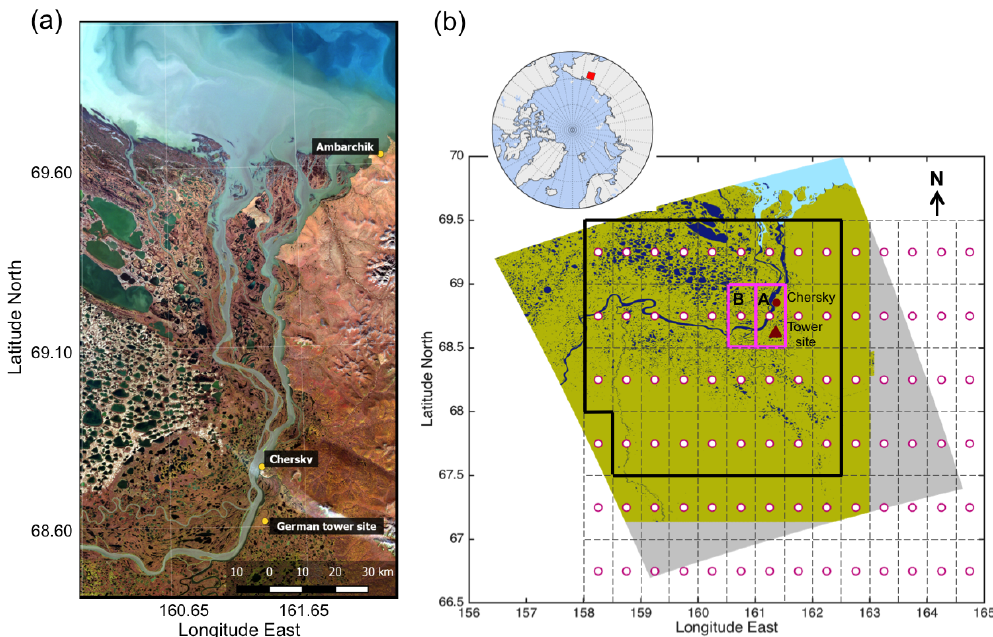
Figure 1. (a) Image from Copernicus Sentinel data (2016) showing the heterogeneous landscape in most of the model domain in Northeast Siberia, also showing the location of nearby cities and the floodplain; (b) geographical location of the model domain used in this study also depicted with the midpoints of the model grid cells (pink circles) and boundaries (dashed lines) underlain by a geoTIFF image (data from 1 to 10 July 2007) from the EAWS product. The boundaries of grid cells A and B are delimited with pink lines. The continuous black line delimits the 35 model grid cells used for the evaluation of modeled inundated areas against the EAWS